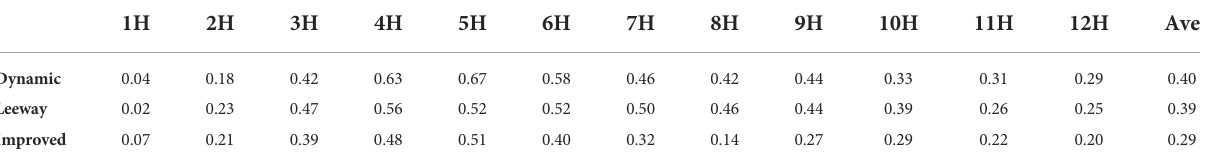
predicted trajectory by the leeway model at 0.21 km. And the total average deviation of the improved trajectory is 0.42 km, which is also smaller than that of leeway trajectory at 0.46 km.